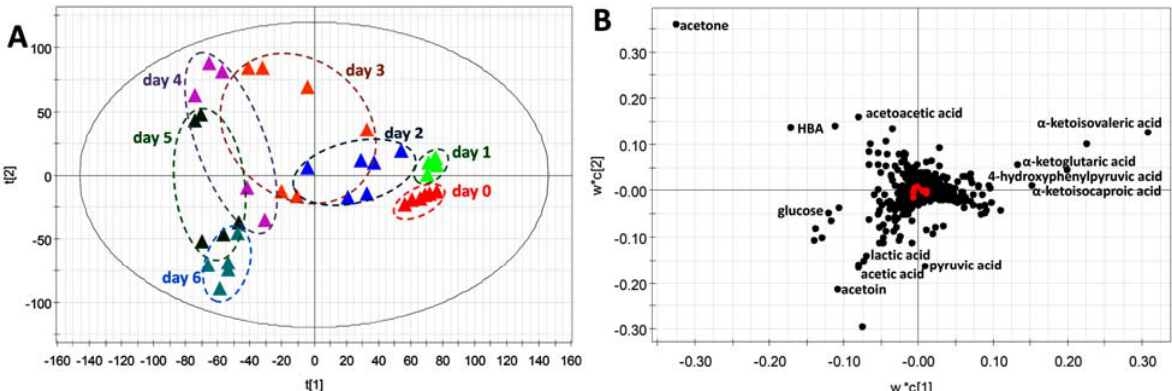
Figure 6. LC-MS-based metabolomic analysis of STZ-induced metabolic changes in mice. Urine samples were derivatized by HQ before LC-MS analysis. ( A ) The score plot of a PLS-DA model on urine samples from control and STZ-treated mice. The t [1] and t [2] values represent the scores of each sample in the principal components 1 and 2, respectively. ( B ) The loading plot of urinary ions contributing to the time-dependent separation of HQ-derivatized urine samples in the PLS-DA model. The w*c [1] and w*c [2] values represent the contributing weights of each ion to the principal components 1 and 2 of the PLS-DA model, respectively. Major urinary ions affected by STZ treatment were labeled with their chemical